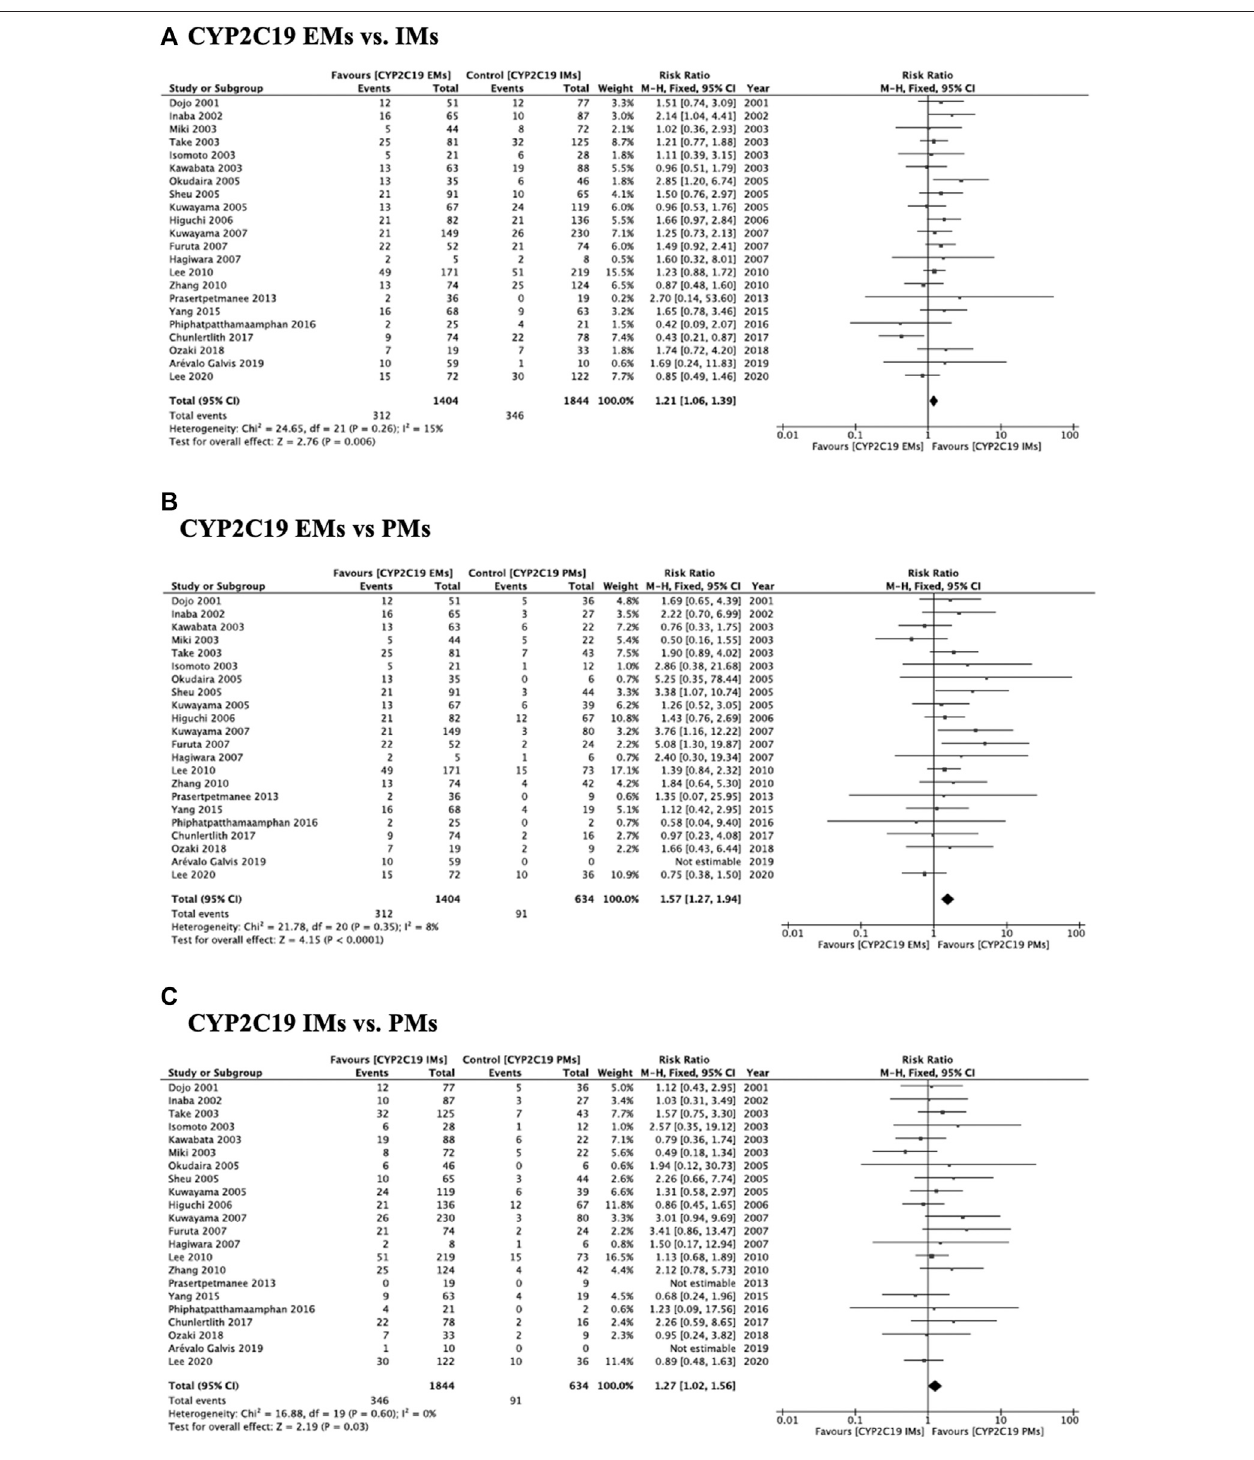
FIGURE 1 | Forest plots of H. pylori cure rates of PPI-amoxicillin-clarithromycin regimen among different CYP2C19 genotypes in the fi xed-effects model. (A) CYP2C19 EMs vs IMs, (B) EMs vs PMs and (C) IMs and PMs.